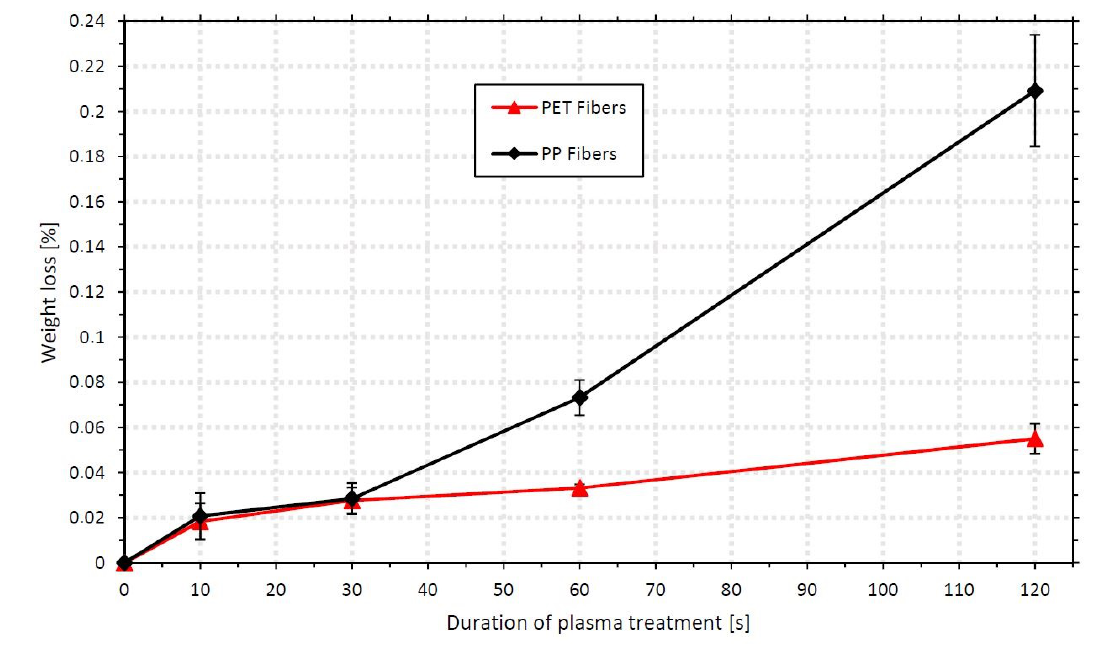
Figure 5. Relation between fibers weight loss and duration of plasma treatment obtained before and after plasma treatment.